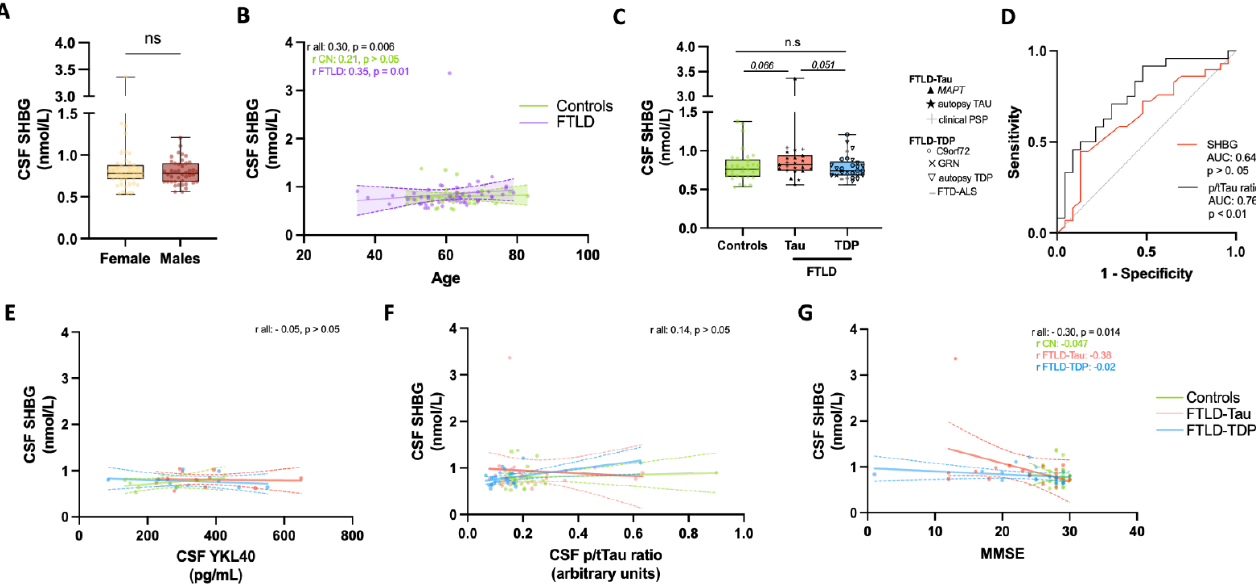
Figure 1. CSF SHBG levels of FTLD of patients with known underlying neuropathology. ( A ) Box-dot plots depict the CSF SHBG levels between males and females. ( B ) Spearman correlation analysis depicts an association between SHBG and age, which was mainly driven by the FTLD group (purple). Correlation coefficient and p value are presented in inserts. Regression line and 95% confident intervals for FTLD (purple) and controls (green) are included. ( C ) Box-dot plots depict the CSF SHBG levels between controls, FTLD-Tau and FTLD-TDP. Specific symbols depict patient subgroups within each pathological subtype. Exact p values after post-hoc analysis are included. ( D ) Receiver operator characteristic (ROC) curve depicting the predictive performance of CSF SHBG (red) or CSF p/tTau ratio (black) discriminating FTLD-Tau from FTLD-TDP subtypes. The exact area under the curve (AUC) and p value are presented in inserts. ( E – G ) Scatter plots depict the correlation between CSF SHBG with ( E ) CSF YKL40, ( F ) p/tTau ratio and ( G ) MMSE score. Correlation coefficient and p value are presented in inserts. Regression line and 95% confident intervals are included. The different diagnostic groups are depicted by colors. CN, controls; FTLD, Frontotemporal lobar degeneration; PSP, progressive supranuclear palsy; FTD-ALS, Frontotemporal dementia—Amyotrophic lateral sclerosis; ns,